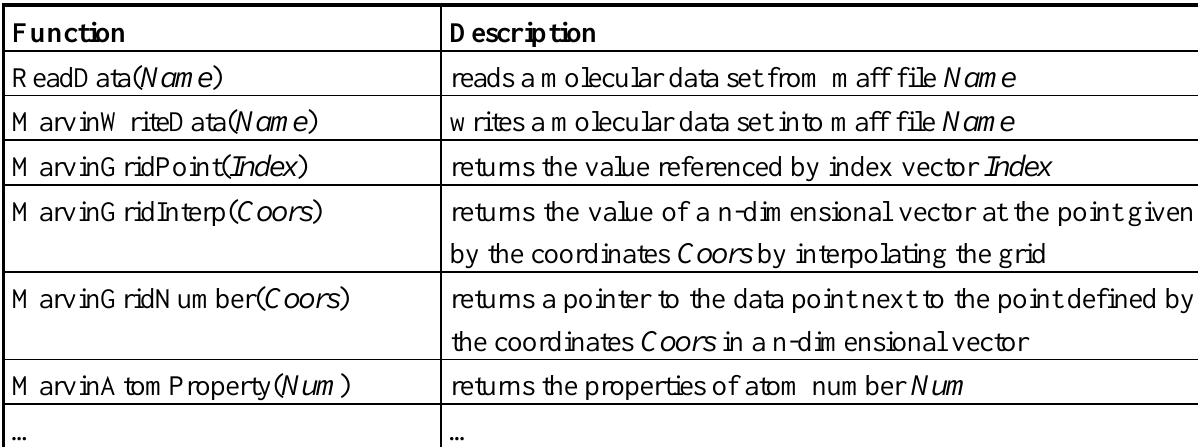
Table 3: marvin runtime library: Example functions for data handling Function